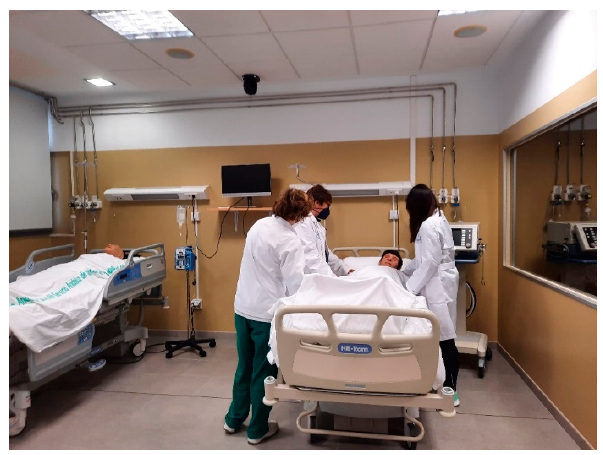
Figure 1. The simulated scenario. The FGs were monitored by the lead researcher. The duration of the FGs varied from 20 to 40 min. Sociodemographic data was collected from all participants before beginning the FGs. The responses of participants in FGs were audio-recorded and transcribed